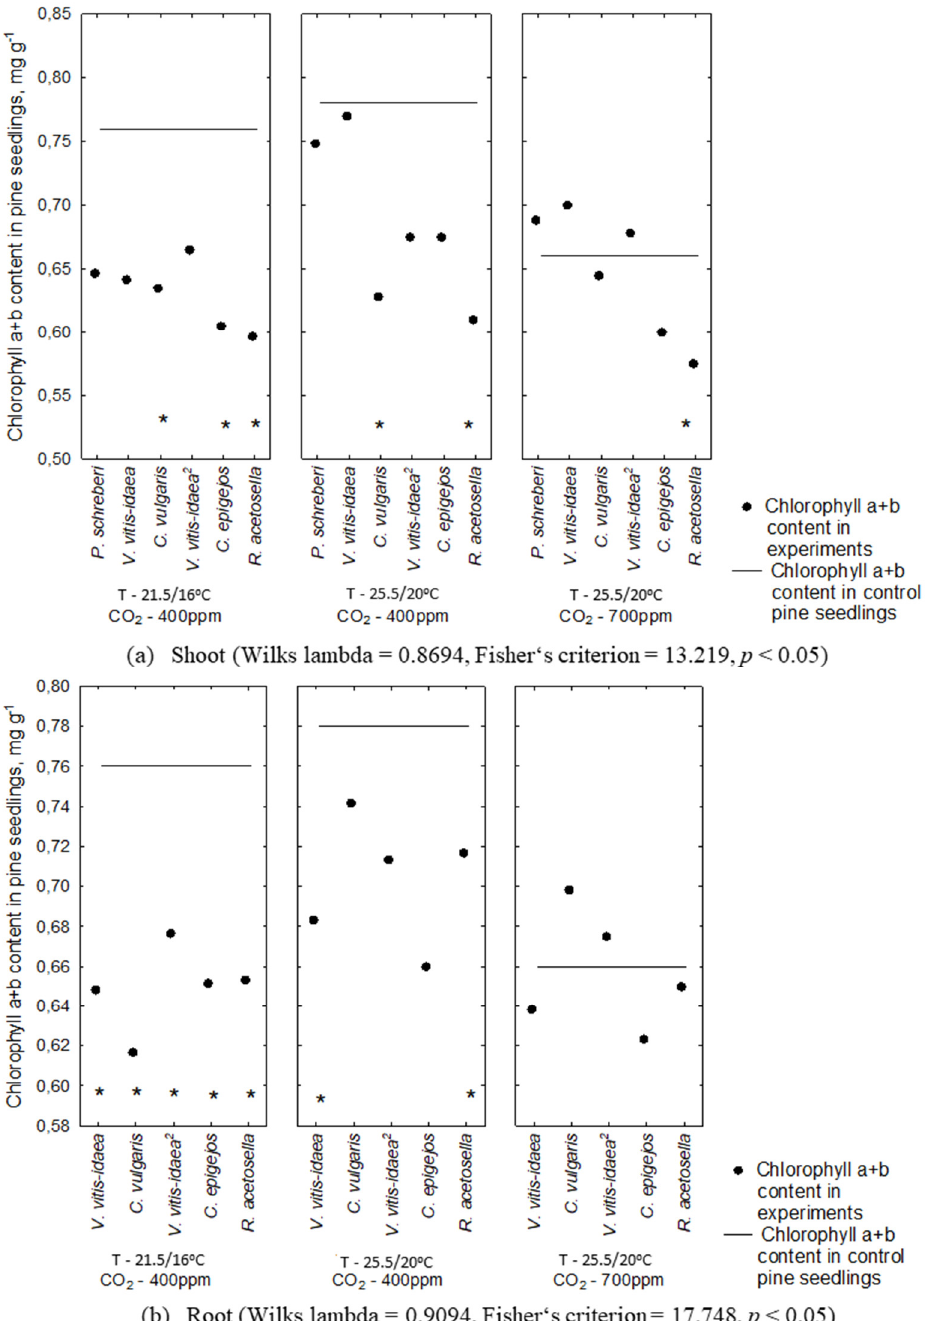
Figure 7. Chlorophyll concentration in the Scots pine seedlings under the effect of plant-donor shoot ( a ) and root ( b ) extracts under different CO 2 and temperature conditions (*— p < 0.05 post-hoc LSD test). Control conditions (21.5/16 ◦ C and 400 ppm CO 2 concentration), temperature increases of 4 ◦ C compared to the current conditions (25.5/20 ◦ C and 400 ppm CO 2 concentration), increasing temperature with higher CO 2 concentration conditions (25.5/20 ◦ C and 700 ppm CO 2 ). ( 2 )—dominant species of 2-year-old clear-cuts.